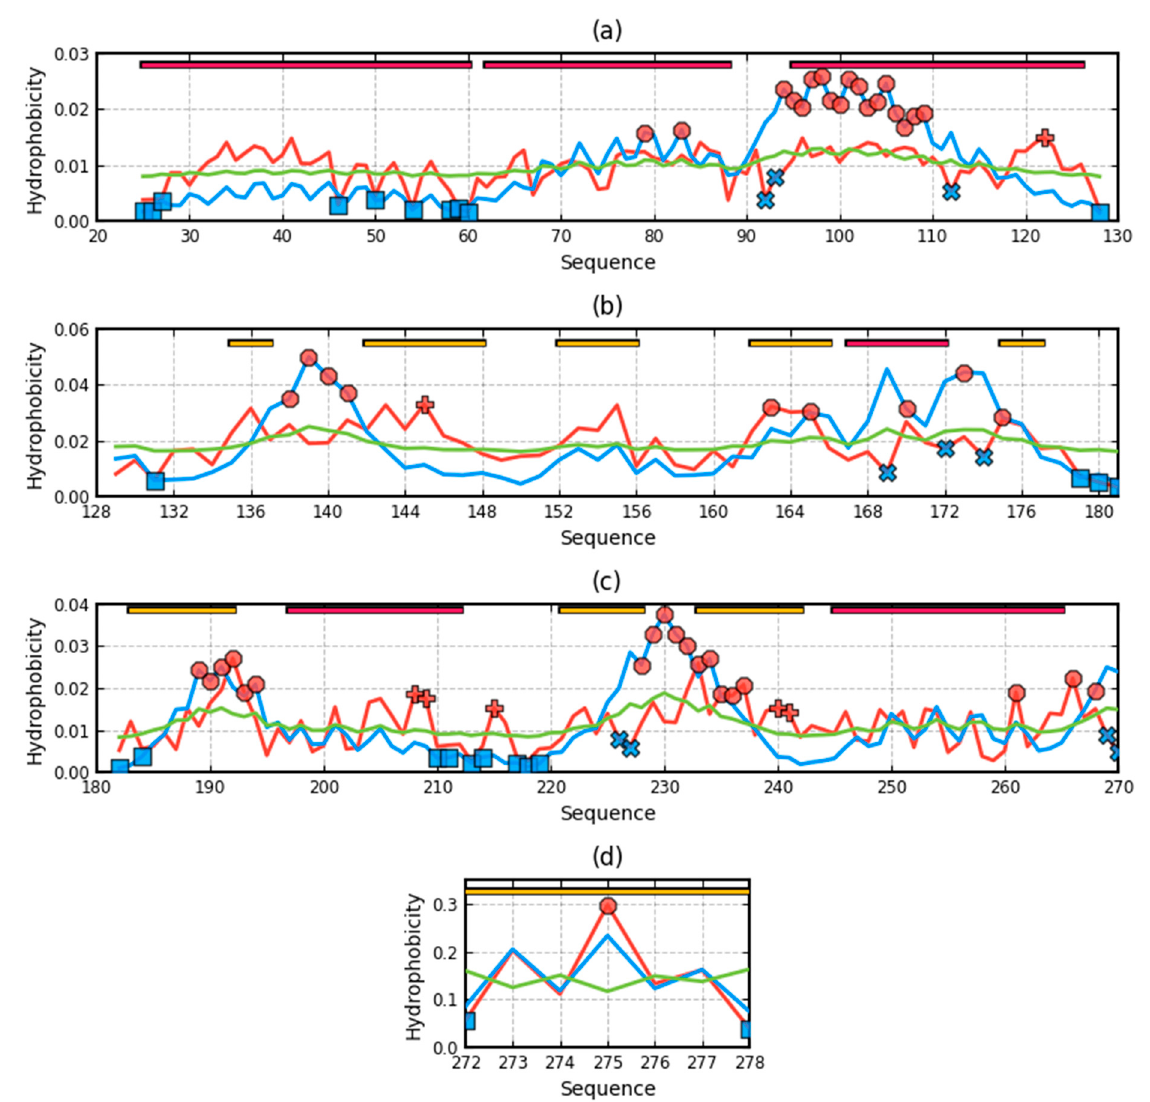
Figure 6. Profiles T, O, and M for chain A treated as part of the complex (3D Gauss function generated for the complete complex) ( a )—dom1, ( b )—dom2, ( c )—dom3, ( d )—beta-barrel Blue—T distribution, red—O distribution, green—M distribution. Bars on top represent fragments of secondary structure: red—helix, yellow—beta-structure. Red circles—residues potentially creating a hydrophobic core, blue “X”—residues of hydrophobicity deficiency—here residues engaged in channel building, red “+”—residues expressing hydrophobicity excess on the surface potentially engaged in protein-protein complexation. The blue squares—residues on the surface representing low hydrophobicity—a status accordant with FOD criteria.